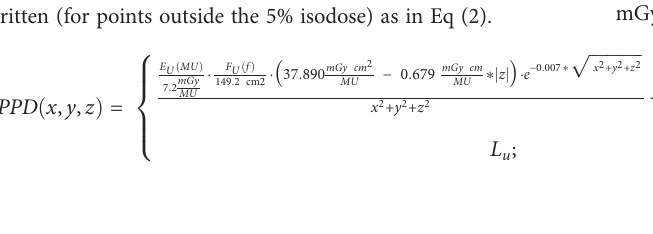
depicted in Figure 4. The average absolute difference between The fi tted constant coef fi cients are ( Model calibration ) A 1 Periphocal 3D dose estimations and the TLD dose = 37 : 890 ± 1 : 415 ( mGy cm 2 ), A 2 = 0 : 679 ± 0 : 074 ( mGy cm ), A 3 MU MU measurements, relative to the latter, is 16.8%, with a = 0.007 ± 0.004 ( cm − 1 ). maximum difference on one point of 15.8 mGy/Gy